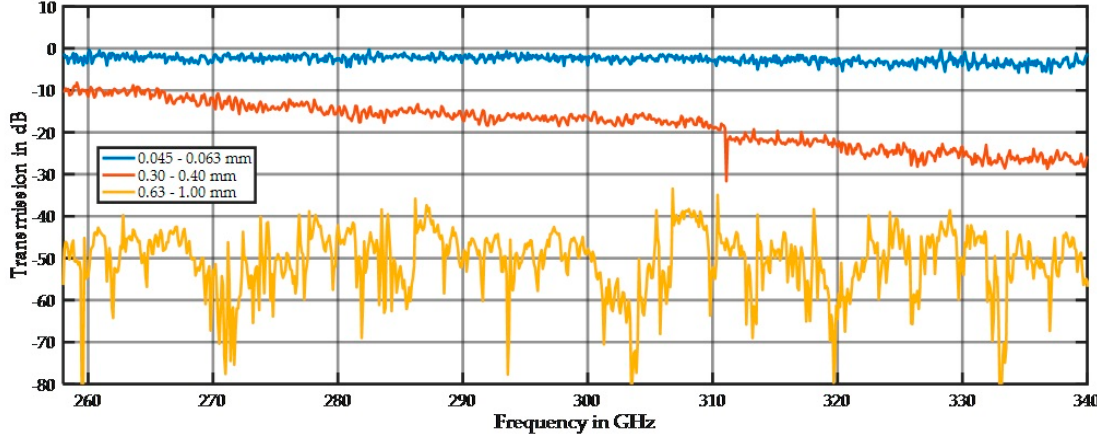
Figure 8. Spectral distribution of three quartz particle size fractions at 11 mm sample thickness.